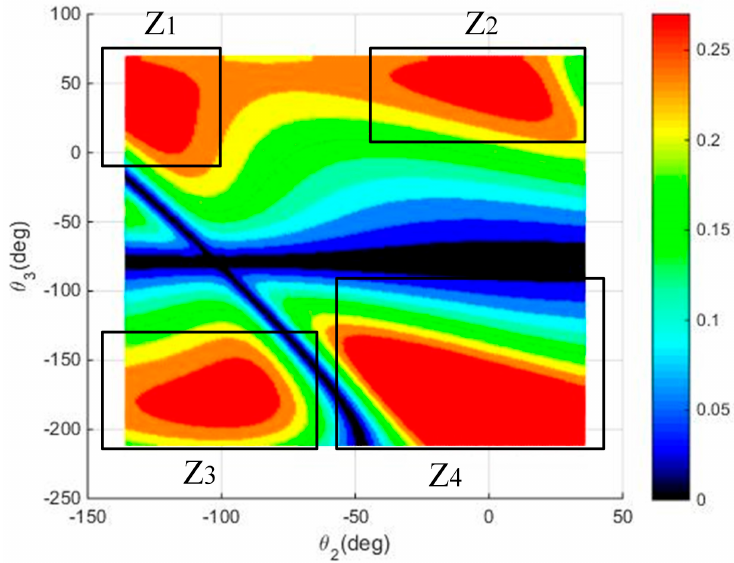
( J ) − 1 in the 2 and 3 joint AW